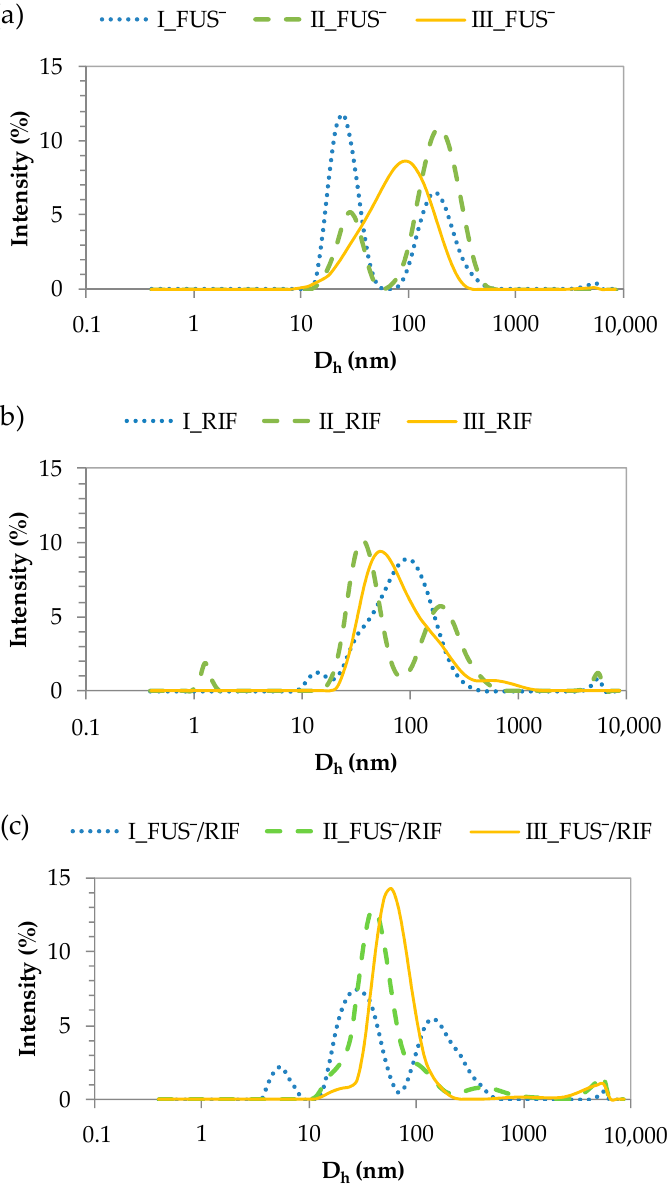
Figure 4. DLS histograms for particles in single systems with ( a ) FUS − , ( b ) RIF, and ( c ) dual systems.